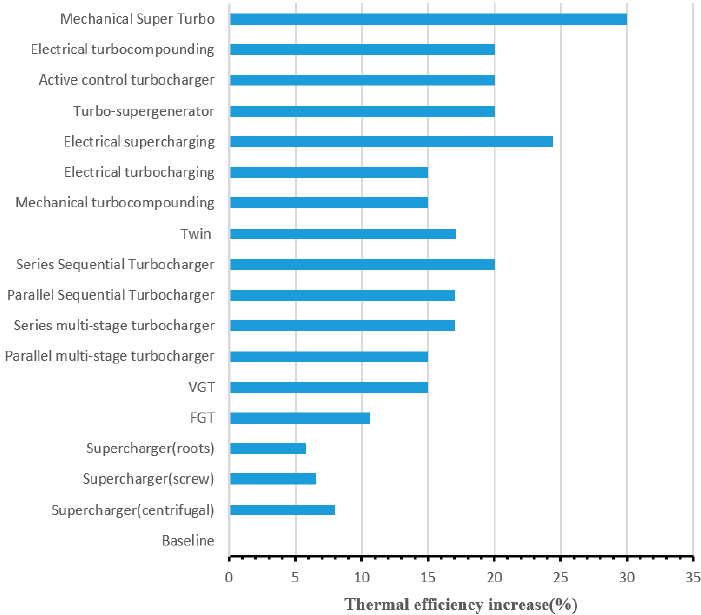
Figure 6. Effect of various types of boosting systems on brake thermal efficiency [40,105] .